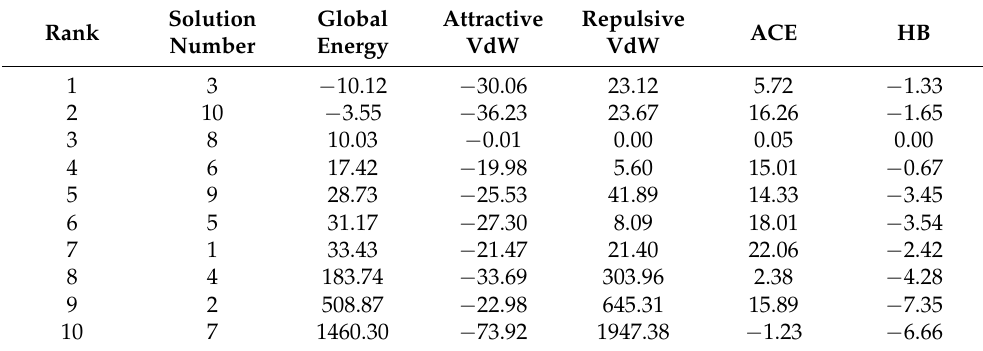
Table 12. Solutions of TLR-4 vaccine by FireDock. For each term below, KJ · m − 1 represents the equivalent amount of energy.